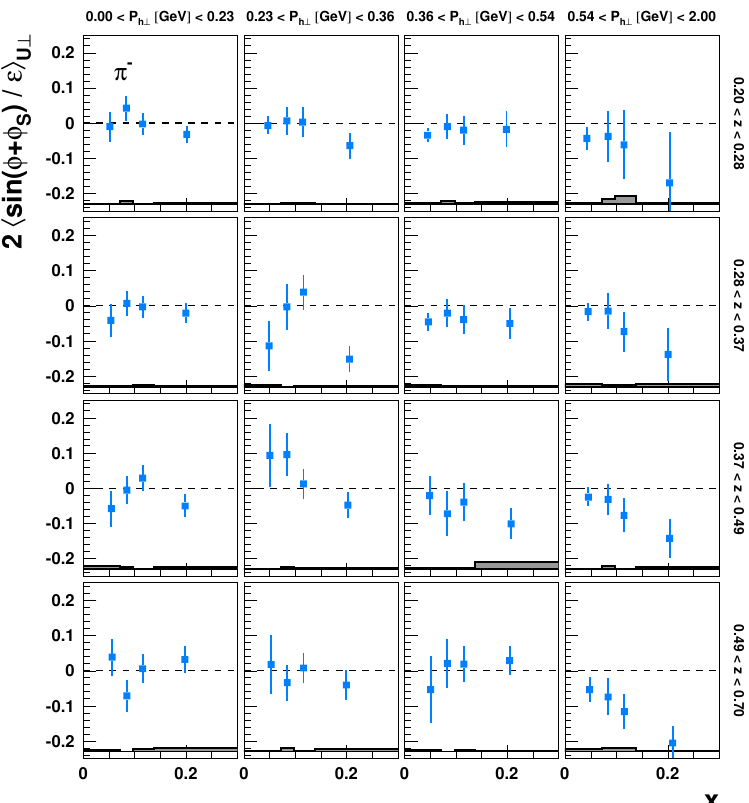
Figure 9 . Collins SFA for π − extracted simultaneously in bins of x , z , and P h ⊥ , presented as a function of x . Systematic uncertainties are given as bands, not including the additional scale uncertainty of 7.3% due to the precision of the target-polarization